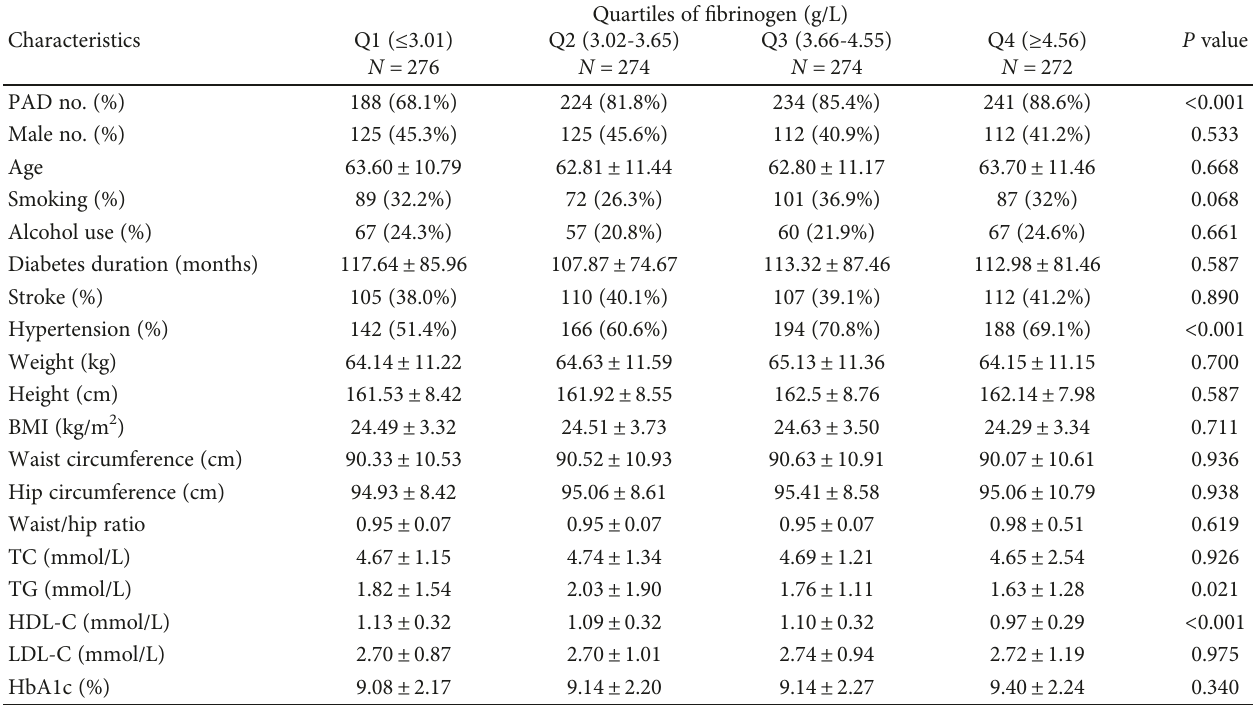
Table 2: Baseline characteristics of 1096 subjects, strati fi ed by quartiles of fi brinogen.